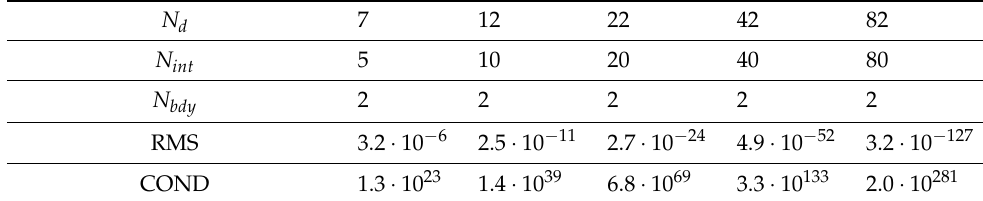
Table 1. 1D experiment, c = 12, b 0 = 1, N t = 501. N d 7